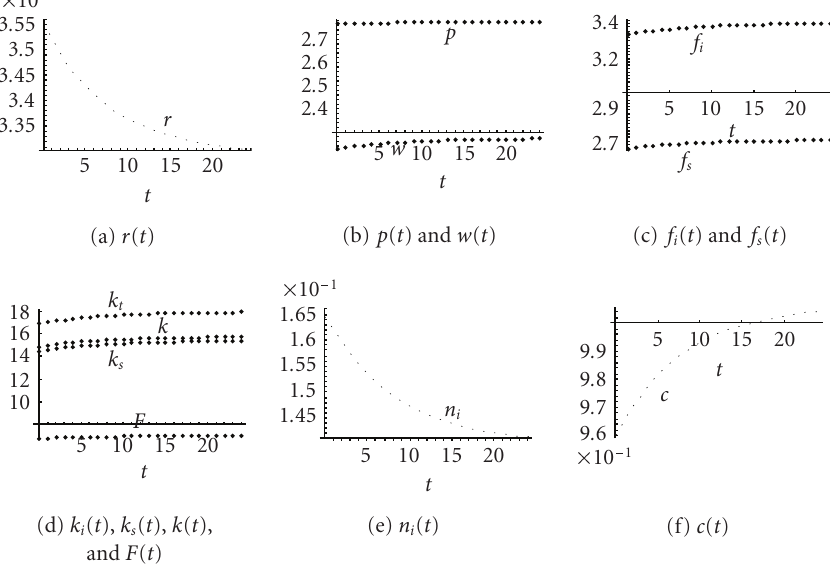
Figure 4.2. The motion of the